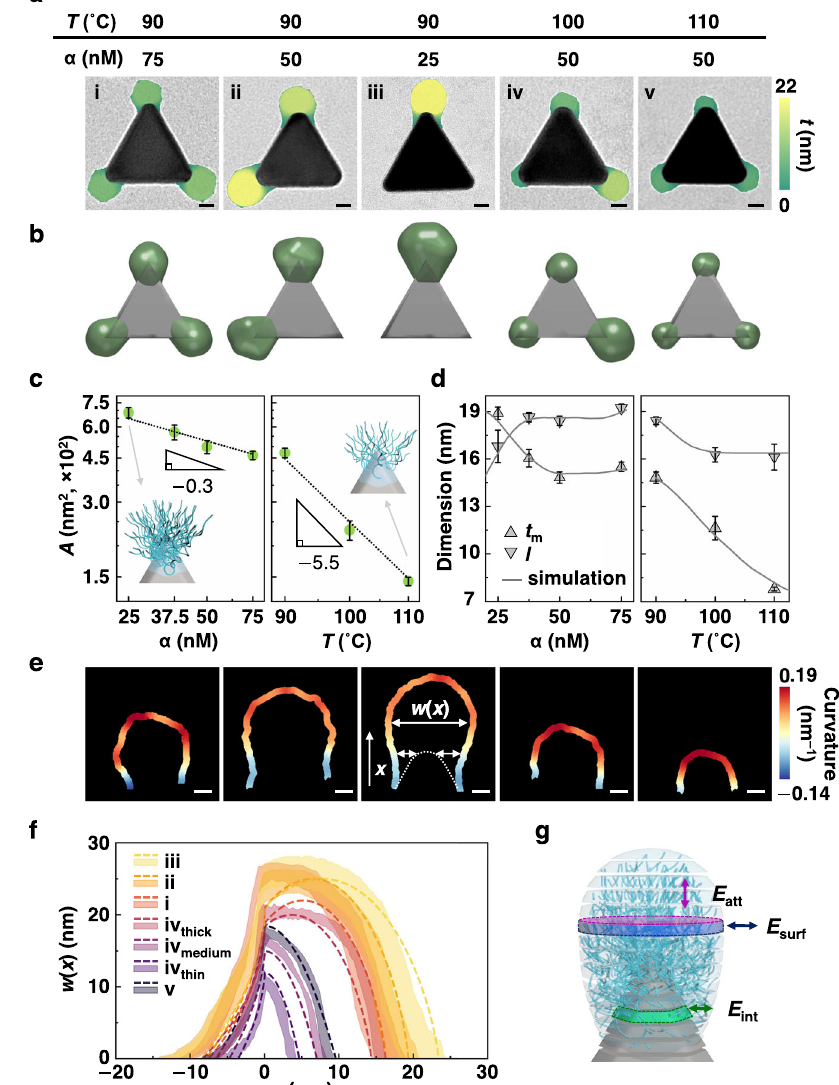
Fig. 3 | Nanometer precision in size and shape of patches from asymmetric grafting. a Representative TEM images of patchy prisms. The patches are color- codedtotheirlocalthickness t . b Representativesimulatedpatchyprismsobtained at the conditions corresponding to ( a ). c Plots showing patch area A (in 2D pro- jectedTEMview)decreaseswithincreasing α (left,at fi xed T =90°C)and T (right,at fi xed α =50nM)inlog ‒ logscalewithpowerlaw fi tting.Meanvaluesareshownand errorbarsrepresentthestandarddeviation. d Plotsof l and t m asafunctionof(left) α and (right) T from experiments (symbols: mean values and standard deviation) overlaid with predictions from simulation (solid lines). e The contour of the top- mostpatchin( a ),color-coded bylocalsurfacecurvature.Localpatchwidth w ð x Þ is de fi nedasafunctionof x ,anaxisvectorconnectingfromthecentertoeachtipofa